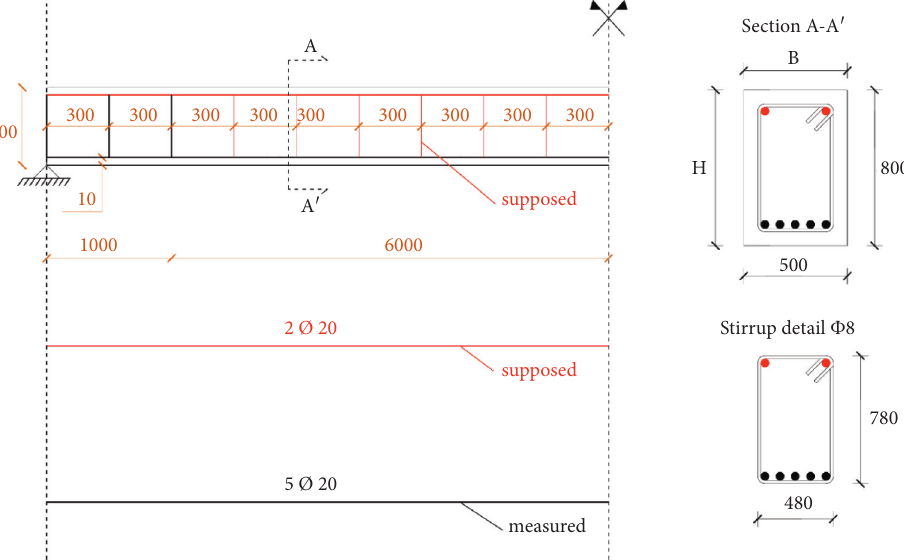
Figure 4: Identification of internal reinforcing bars of the very long span beam: cross section (a) and longitudinal section